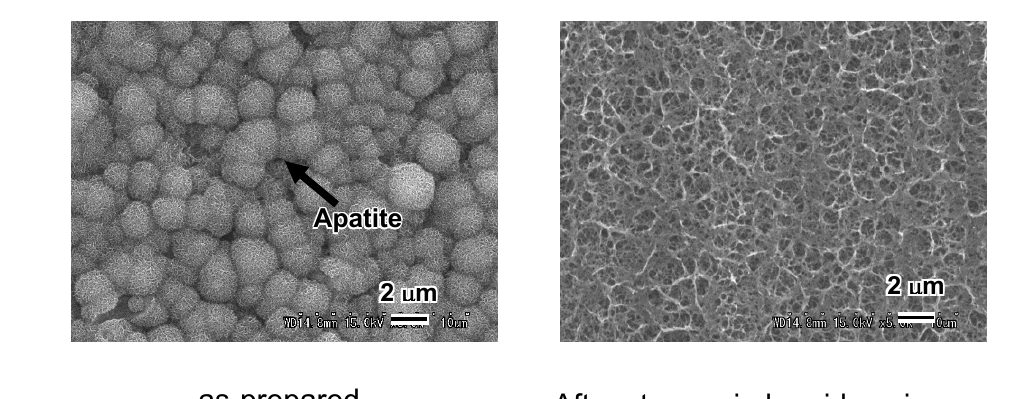
Figure 8. SEM photographs of surfaces of Ti metals soaked in SBF for 1 d, just after NaOH and heat treatments, and after subsequent storage in 95% relative humidity at 80 ° C for 1